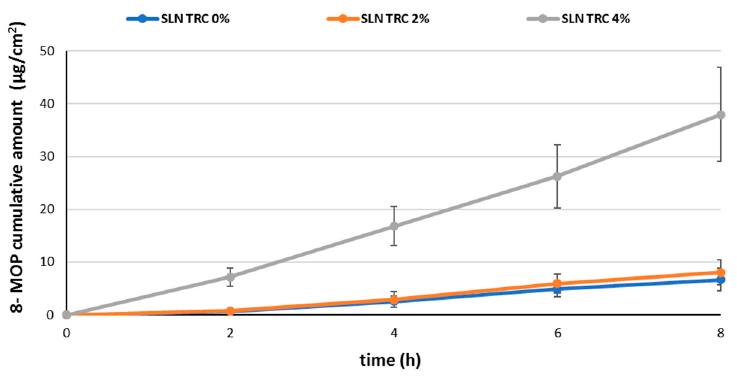
Figure 3. Cumulative amount of permeated 8-MOP per area against time.